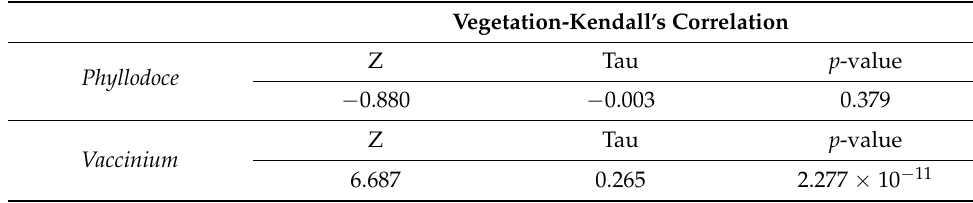
Table 8. Kendall’s correlation between the density of establishment and different vegetation cover types for the whole study